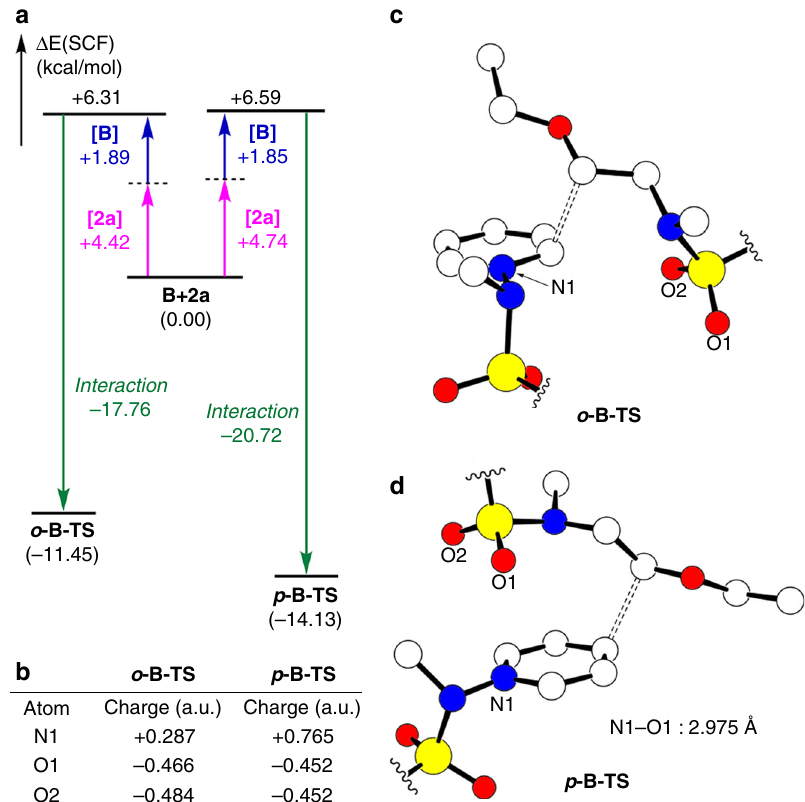
Fig. 4 Distortion-interaction analysis. a Distortion-interaction analysis of o -B-TS and p -B-TS . [ 2a ] and [ B ] indicate the structural distortion energy of radical and pyridinium fragments from the corresponding intermediates 2a and B to each transition state geometries. b Atomic charges from the electrostatic potential of o -B- TS and p -B-TS . Charges are shown in the atomic unit (a.u.). c Optimized structure of o -B-TS . d p -B-TS . p -tolyl groups and hydrogen atoms are omitted for clarity